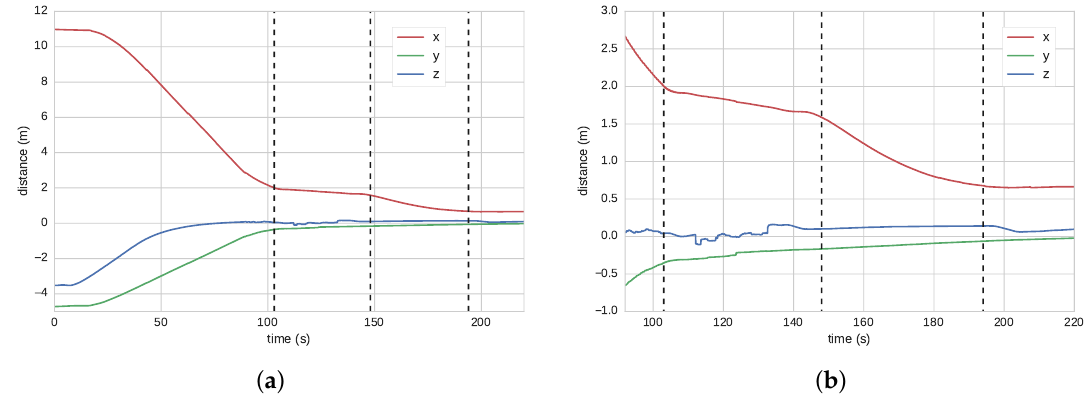
Figure 8. ( a ) vehicle position, estimated in real-time by the on-board localization filter, with respect to panel axes during a docking maneuver; and ( b ) zoom of the last part of the experiment shown in ( a ).